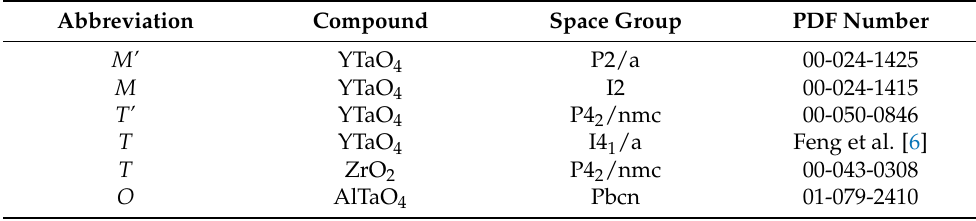
Table 1. List of abbreviations for phases including compound, space group, and International Centre for Powder Diffraction (ICDD) Power Diffraction File (PDF) number or literature for used